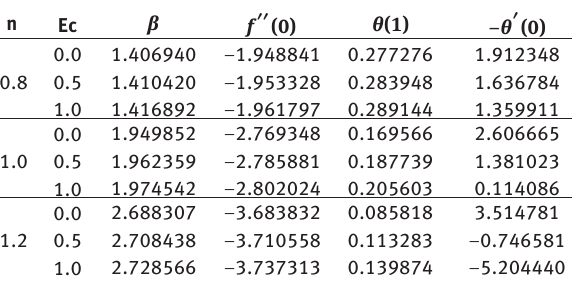
Table 7: Values for β , f (cid:2)(cid:2) (0) , θ (1) and − θ